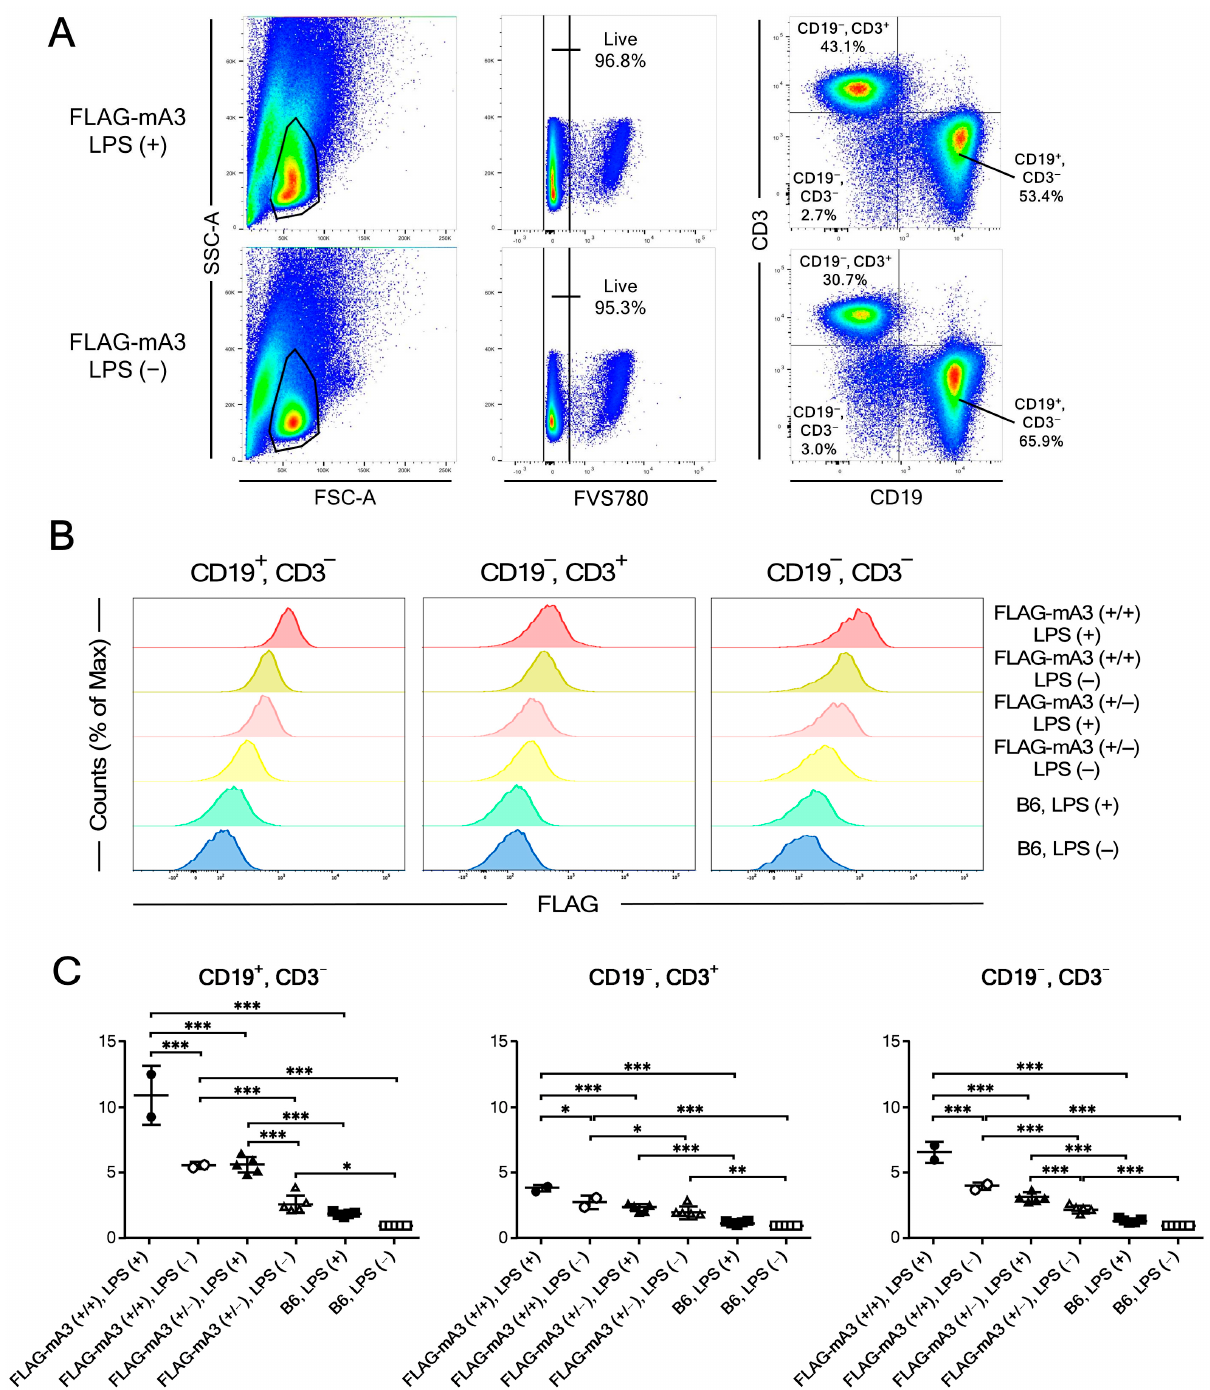
Figure 2. Flow cytometric analyses of intracytoplasmic mA3 expression in different subpopu- lations of spleen cells after culturing with or without LPS. ( A ) Representative gating strategies. Lymphoid cells were gated by using dot plots showing forward and side scatter areas (FSC-A and SSC-A, respectively), and dead cells were eliminated by staining with Fixable Viability Stain (FVS) 780. CD19 + B, CD3 + T, and non-B, non-T cells were gated by using dot plots showing fluorescence intensities of CD3 and CD19. One million events were used to generate shown dot plots. FLAG-mA3 indicates mice heterozygous for the KI allele. ( B ) Representative histograms showing fluorescence intensities of FLAG-tagged mA3 protein (FLAG) in each cell population of cultured spleen cells. Spleen cells from homozygous (+/+) and heterozygous (+/ − ) KI mice as well as those from WT